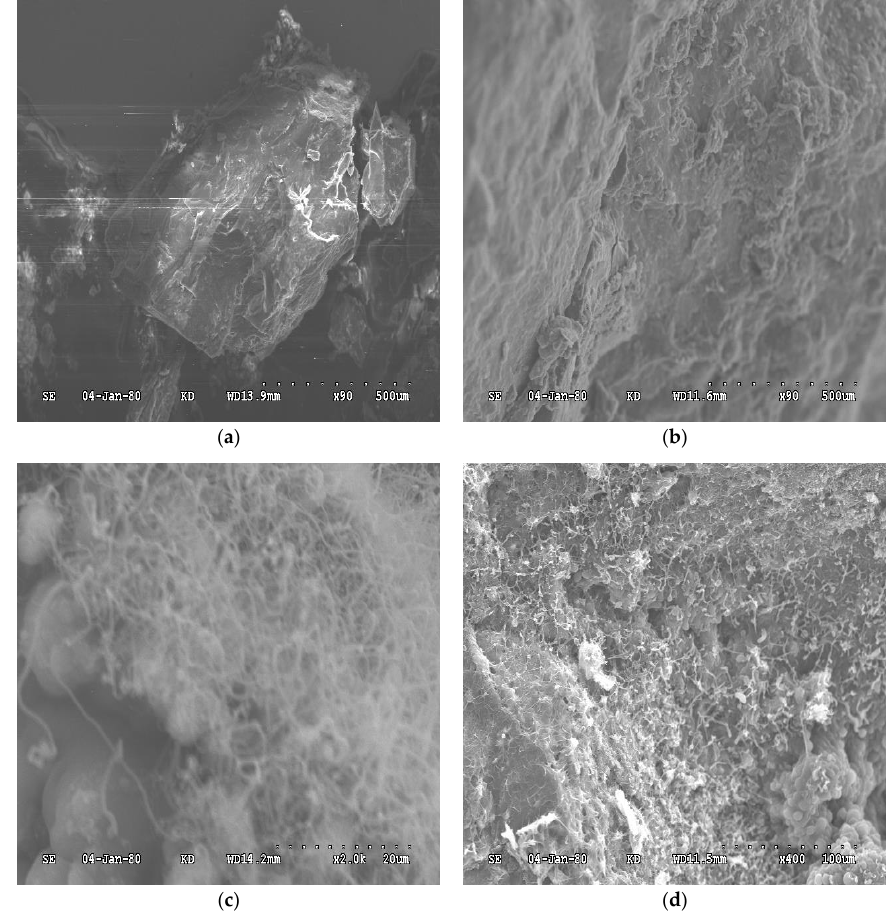
Figure 5. SEM image for the overall structure change: ( a ) before soaking; ( b ) soaking for 5 days; ( c ) soaking for 10 days and ( d ) soaking for 15 days.